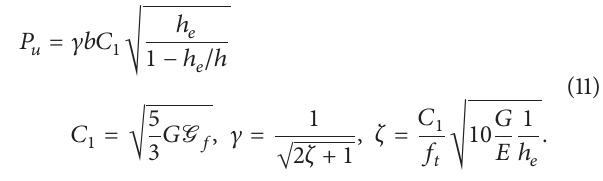
Figure 6: Geometry of end-notched beam as considered in Gustafs- son [33].